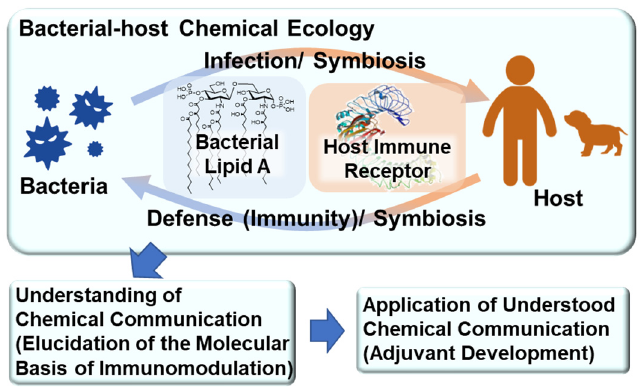
Figure 1. Bacterial–host chemical ecology mediated by lipid A.